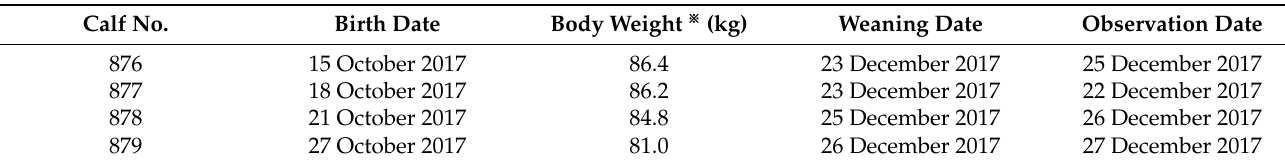
Table 1. Birth date, body weight, weaning date, and observation date of the female Holstein calves monitored during the study to investigate the suitability of wearable cameras for observing juvenile bovine behavior. Calf No.